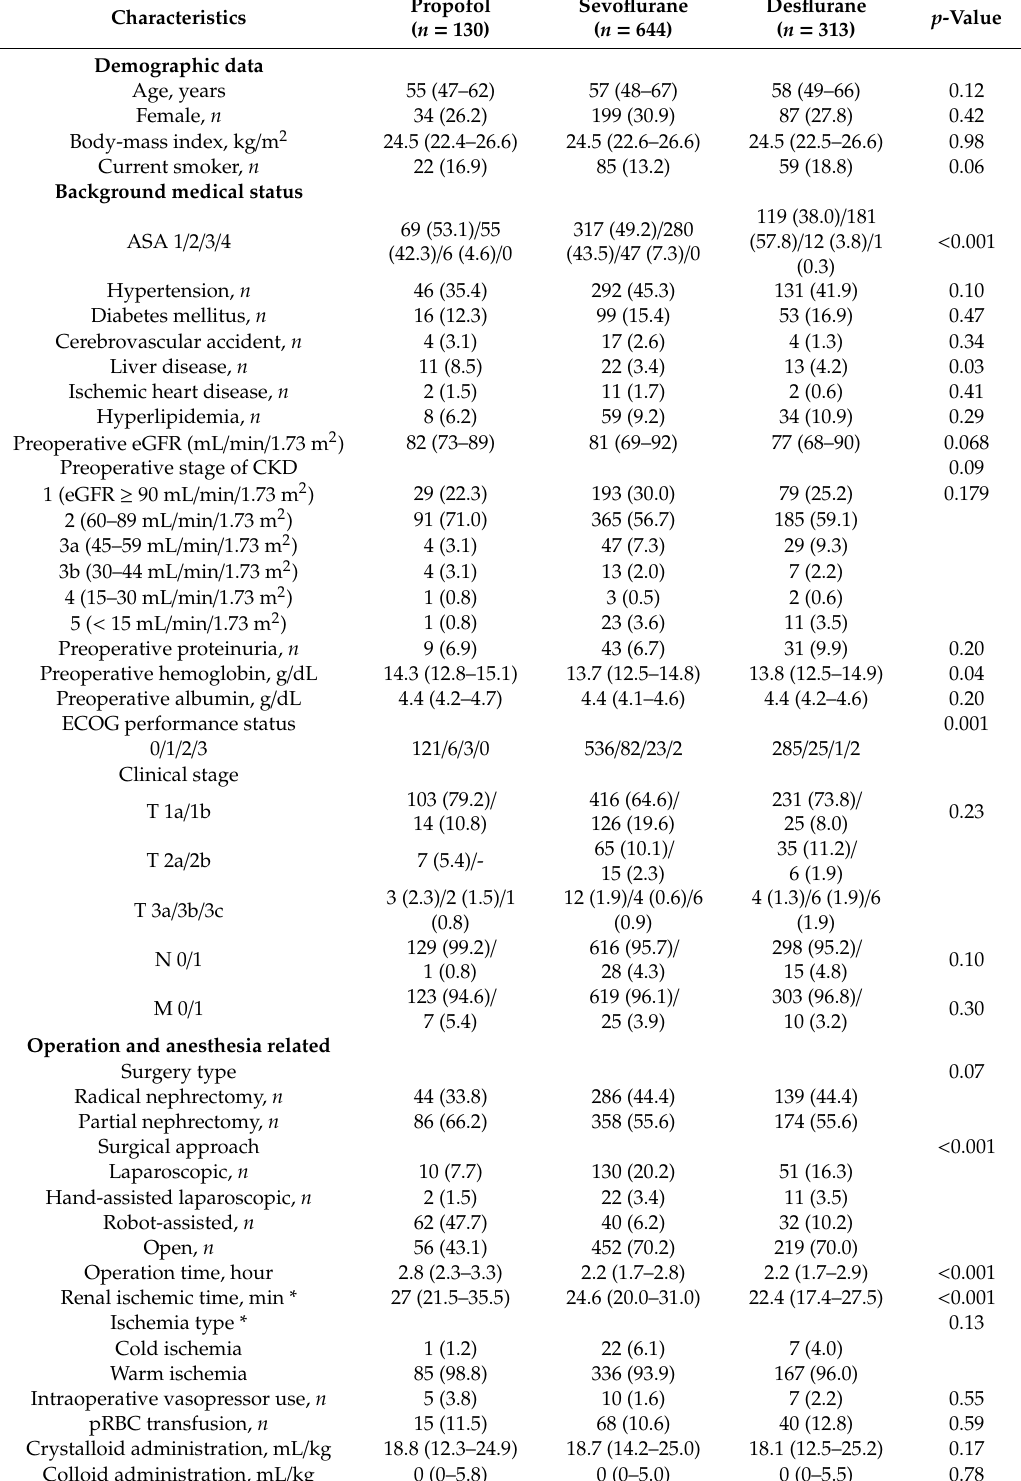
Table 1. Patient characteristics and perioperative